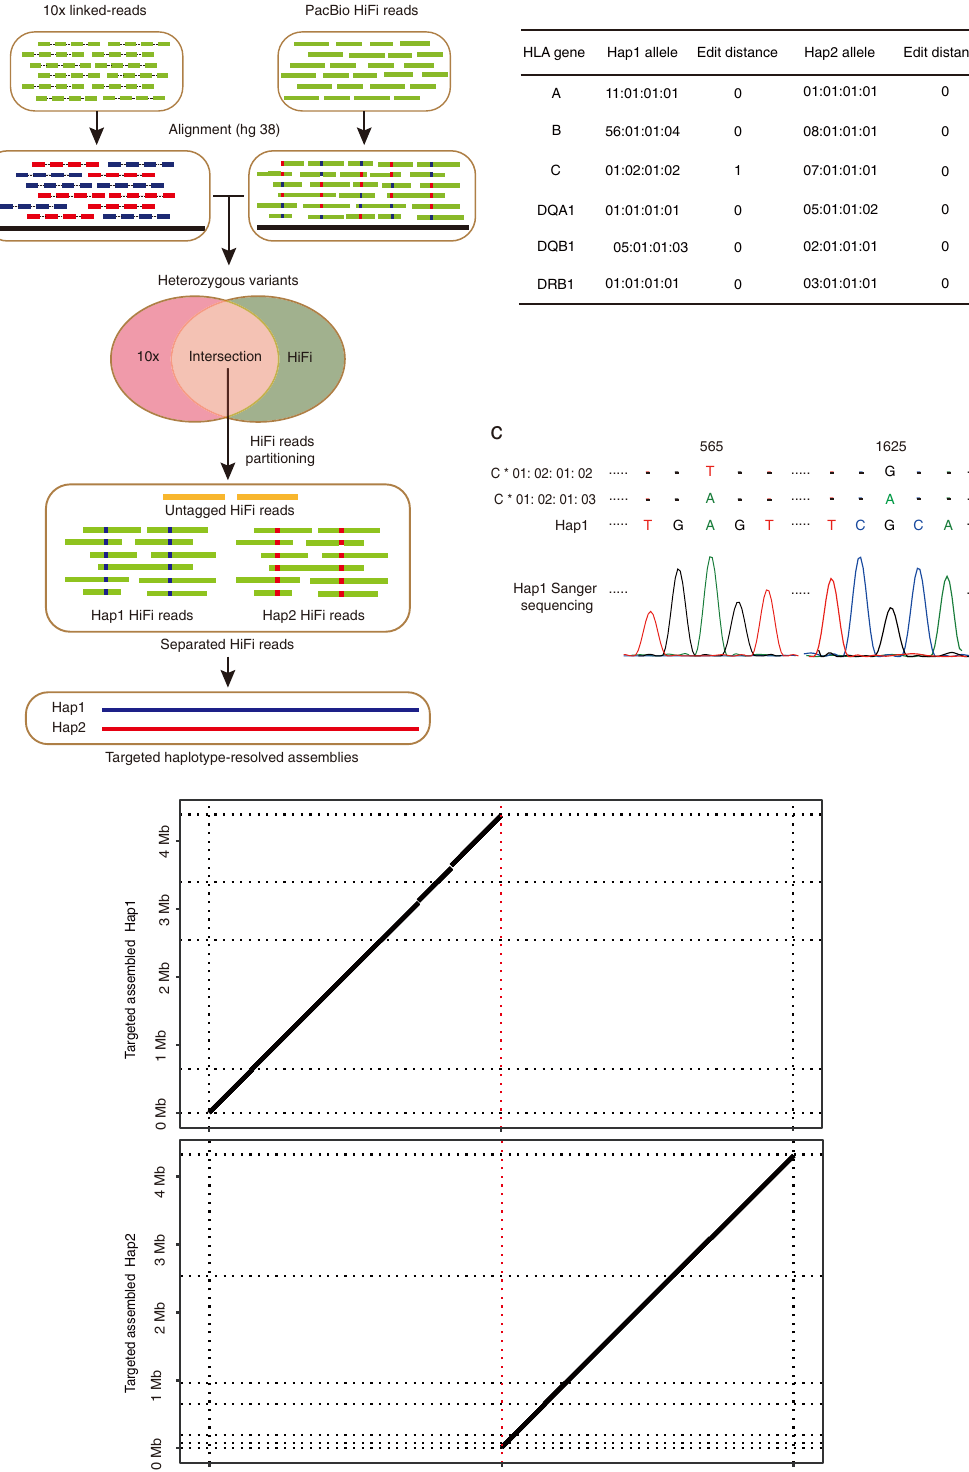
Nature Communications| (2023)